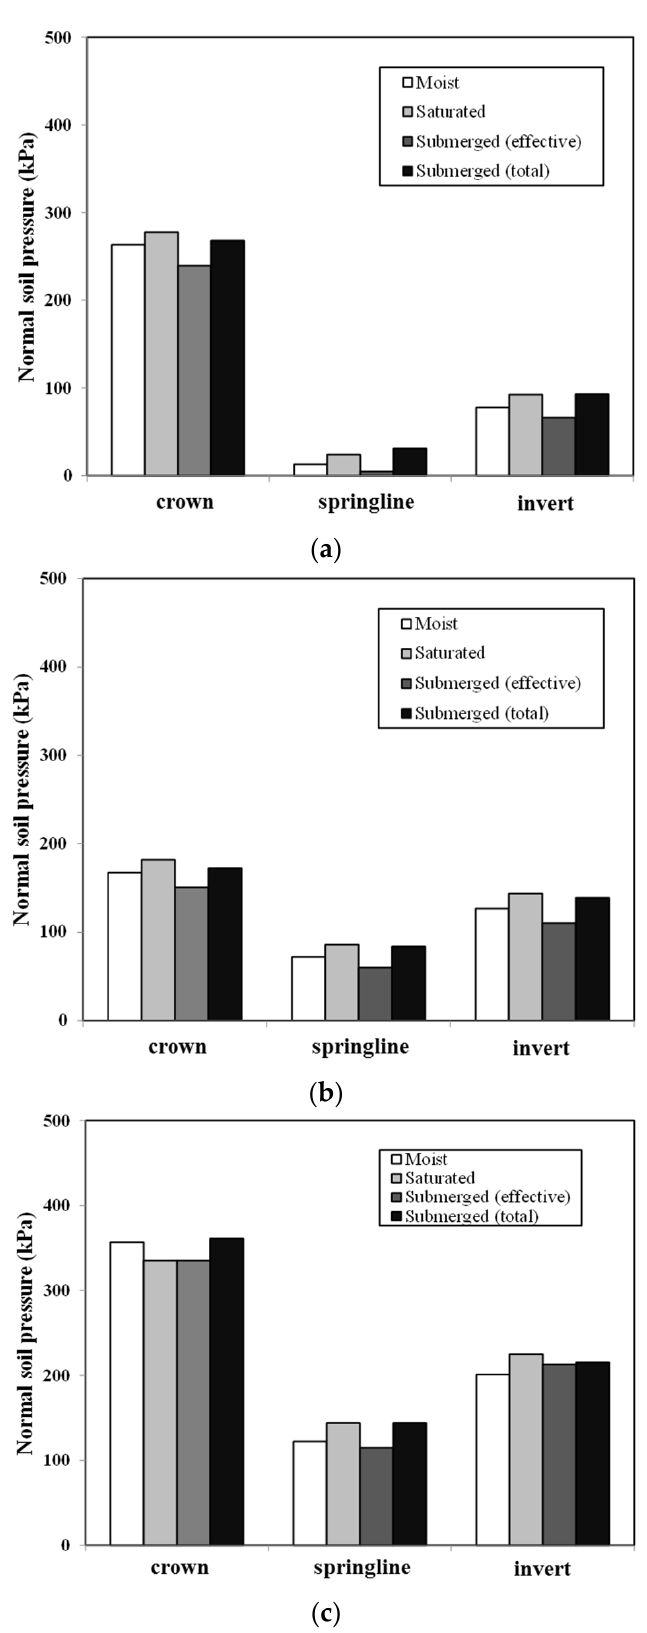
Figure 7. Normal soil pressure distributions at the crown, springline, and invert for moist, saturated, and submerged conditions: ( a ) longitudinal loading, ( b ) transverse loading, and ( c ) uniform loading.